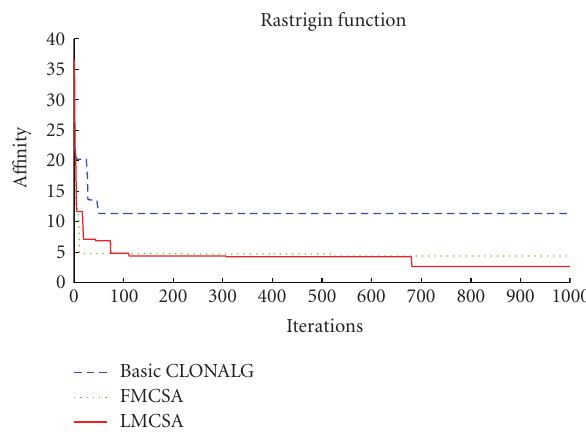
Figure 7: Convergent performances on Rosenbrock’s Function ( f 5).